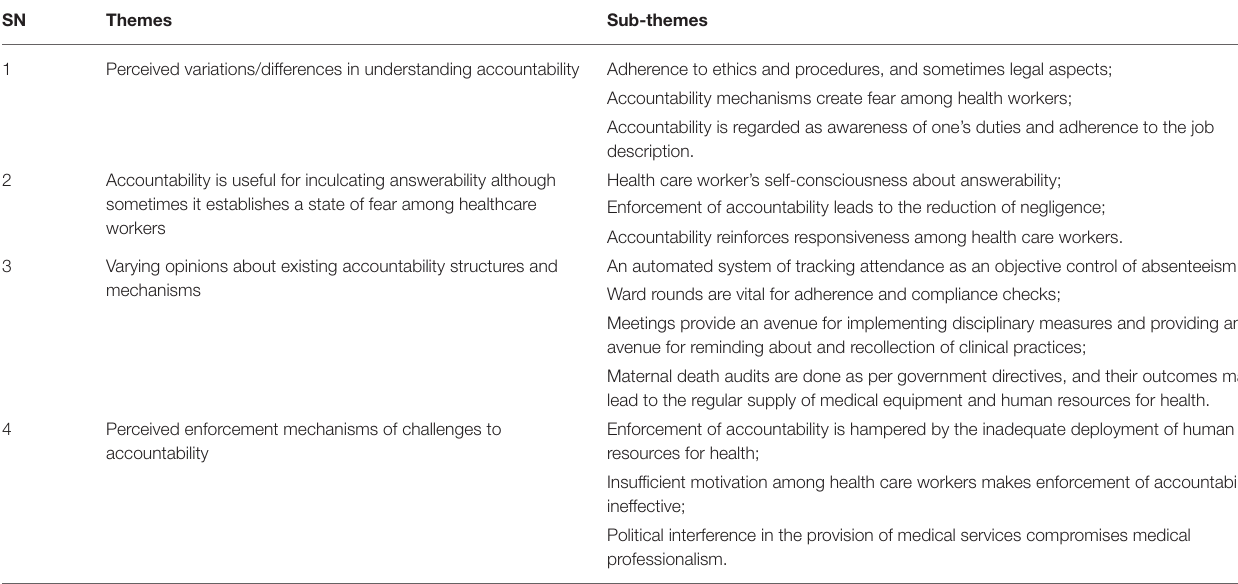
TABLE 1 | Summary of the findings showing themes and sub-themes.